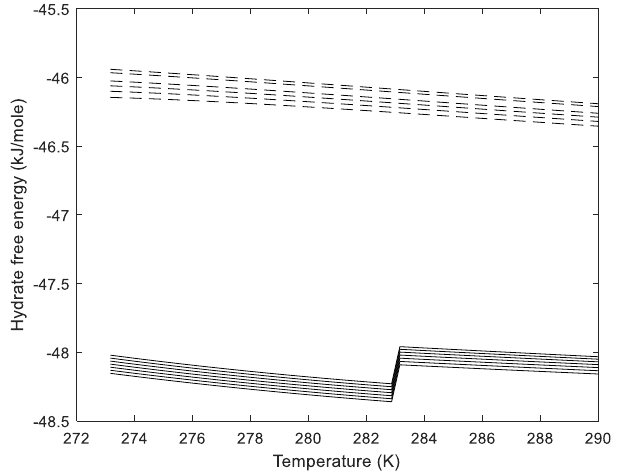
Figure 4. Calculated free energies of CO 2 hydrates (solid) and CH 4 hydrates (dashed). For each set of curves, the lowest curve is the free energy of hydrate formed from pure water, with the curves above corresponding to the following methanol content: 2 mol %, 4 mol %, 6 mol %, 8 mol %, 10 mol %, and finally 12 mol % for the topmost curves of CO 2 and CH 4 , respectively.